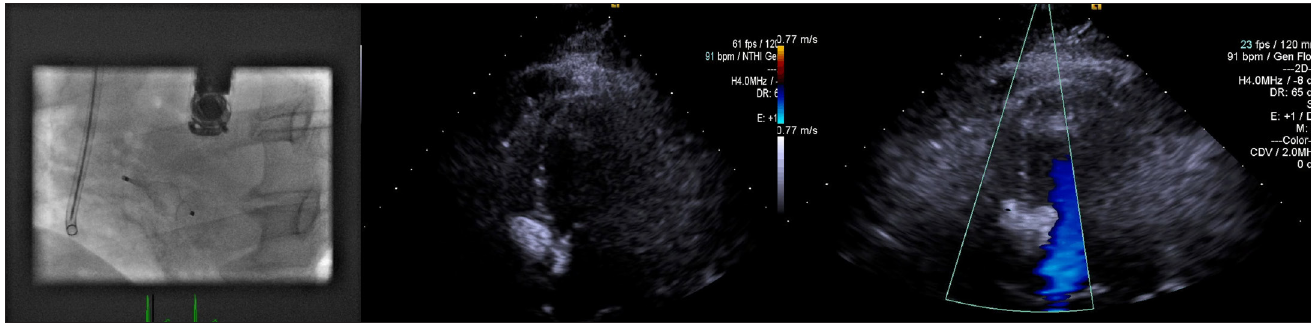
Figure 3. (top left) Fluoroscopic image demonstrates the confirmed position of the device, (top right) transthoracic echocardiogram (TTE) demonstrates the confirmed position of the device, (bottom middle) postoperative 30th day control TTE demonstrates the successful